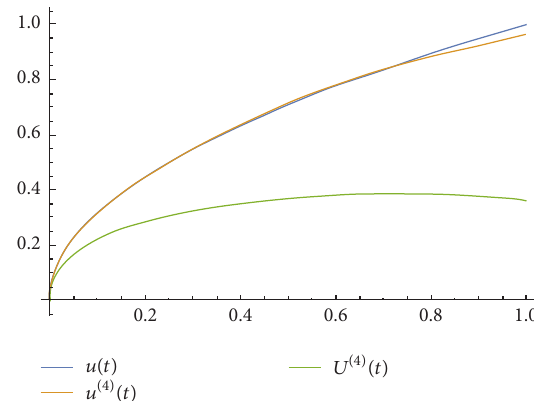
Figure 1: Comparison between the exact and approximate solutions obtained by the ADM for problem